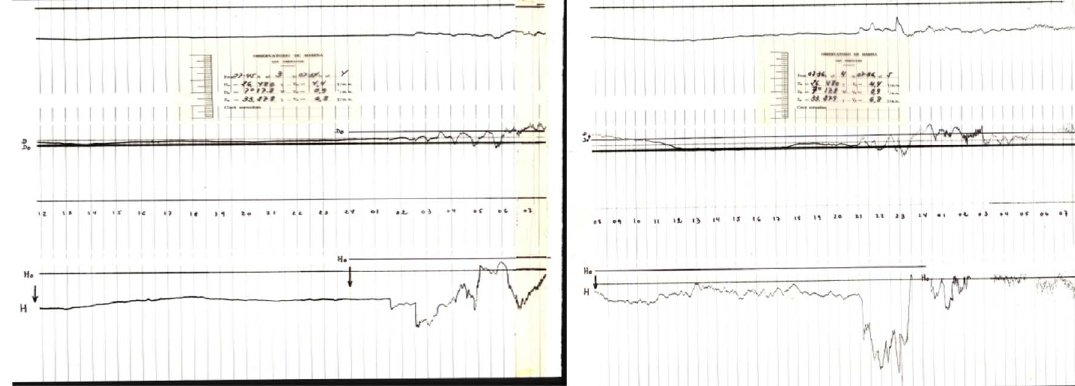
Fig. A.2. San Fernando Observatory H- component variations August 4, 1972 at 08 UT to August 5 at 08